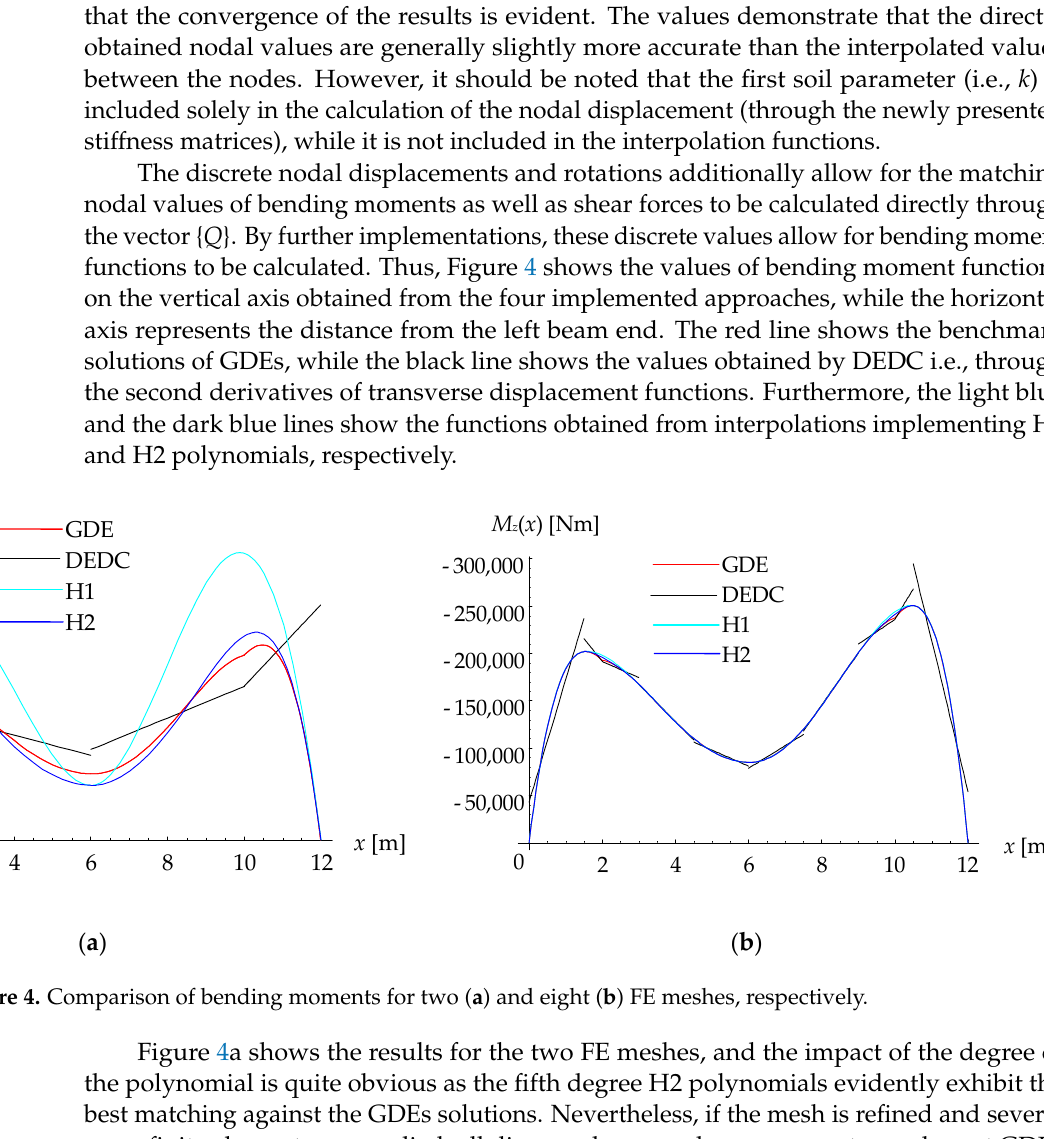
( b ) Figure 5. Comparison of shear forces for two ( a ) and four ( b ) FE meshes, respectively. 4.2. Second Example In this study, the height of the rectangular cross-section was reduced to h = 0.1 m (with K r = 4.32022 ∙ 10 6 Nm obtained from Equation (1)). This value led to the case where k G2 > 4·EI z ·k , consequently meaning that the coefficient λ 2 became an imaginary value (such cases are possible in the engineering practice, although they are less frequent). This changed not only the numerical values of the coupled GDEs solutions but also their